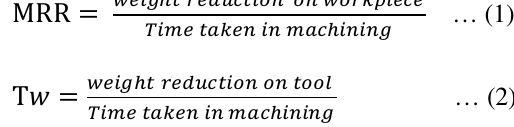
(MRR) and Tool Wear Rate (Tw) are calculated from Tw (g/min) MRR (g/min) Ip Toff Ton No.